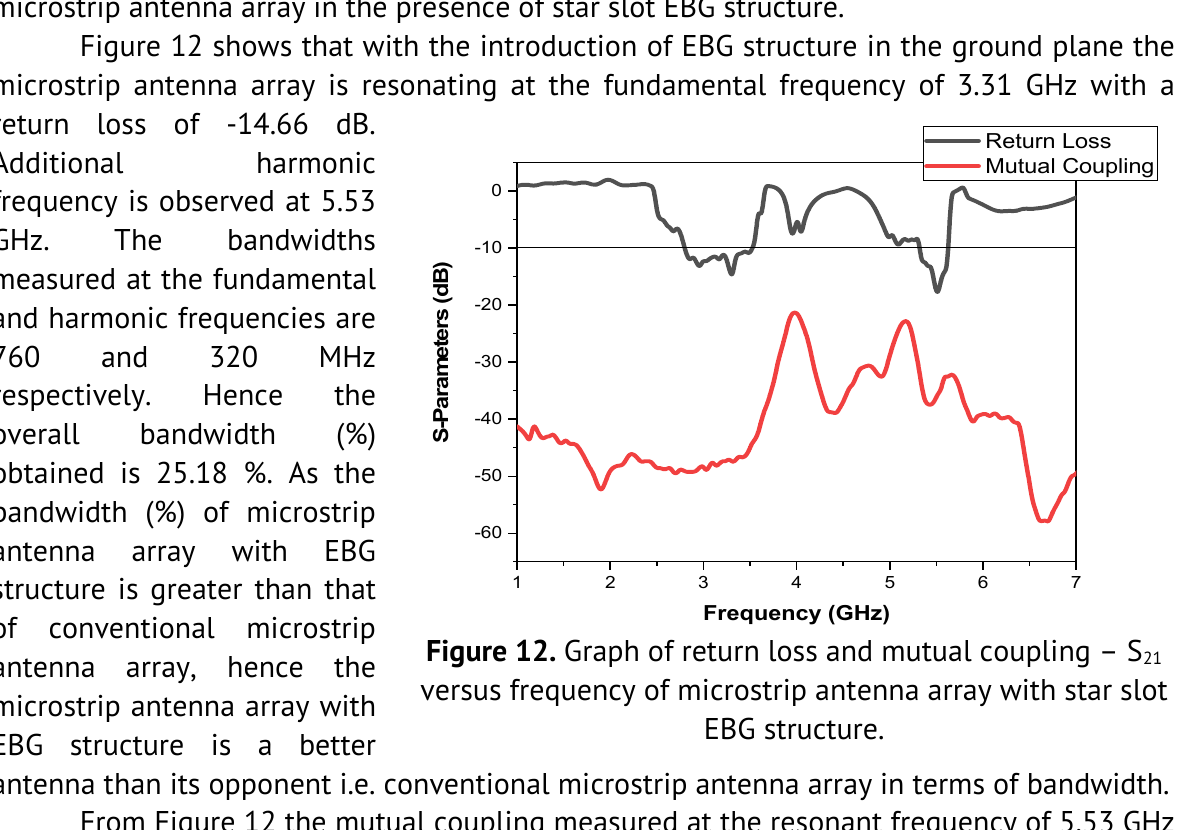
Figure 12. Graph of return loss and mutual coupling – S versus frequency of microstrip antenna array with star slot EBG